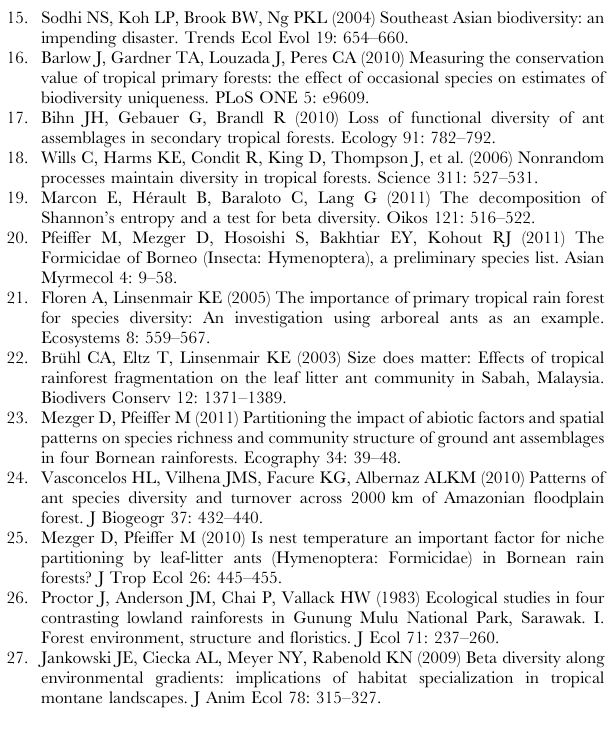
Table S1 List of ant species and their numbers of occurrences in the four forest types. Table S2 Unbiased estimations of alpha, beta and gamma Shannon diversity index * H according to the partitioning procedure of Marcon et al.